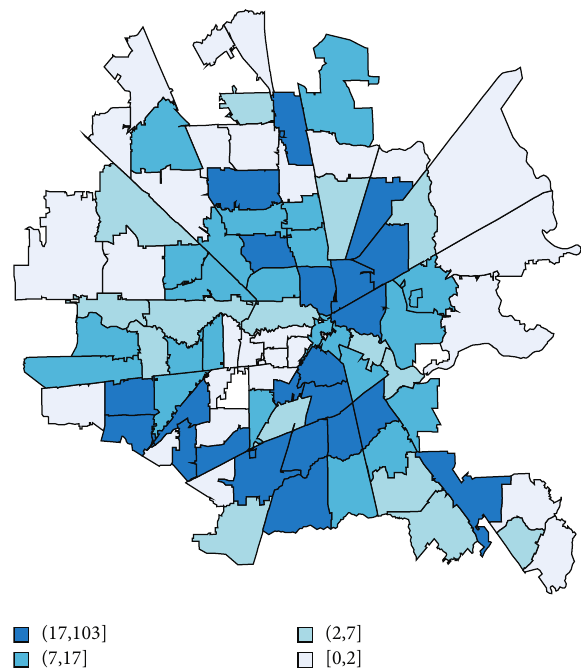
Figure 3: African Americans with cardiac arrest by the Houston metro zip code ( N � 3,952).